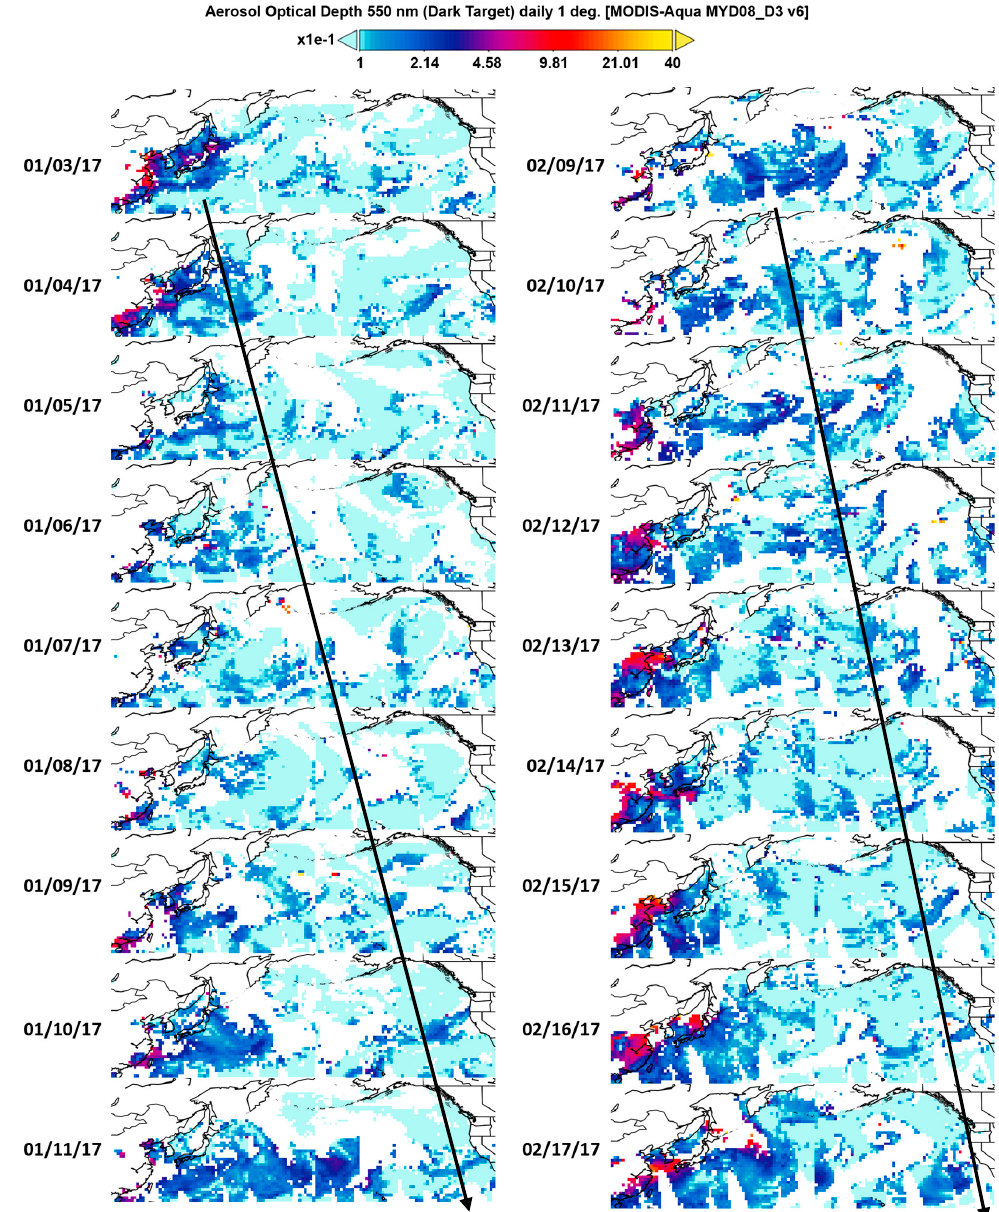
Figure 3. 2017 Daily 1° Moderate Resolution Imaging Spectroradiometer-Aqua Aerosol Optical Depth (MODIS-AOD) (550 nm) for the period of ( a ) 01/03–11, and ( b ) 02/09–17. These are examples of atmospheric river (AR) events that occurred in January and February. Satellite imaging was examined 5+ days before the 01/11 and 02/16 AR events. Black lines represent aerosol particulates being transported across the Northern Pacific during AR event weeks.